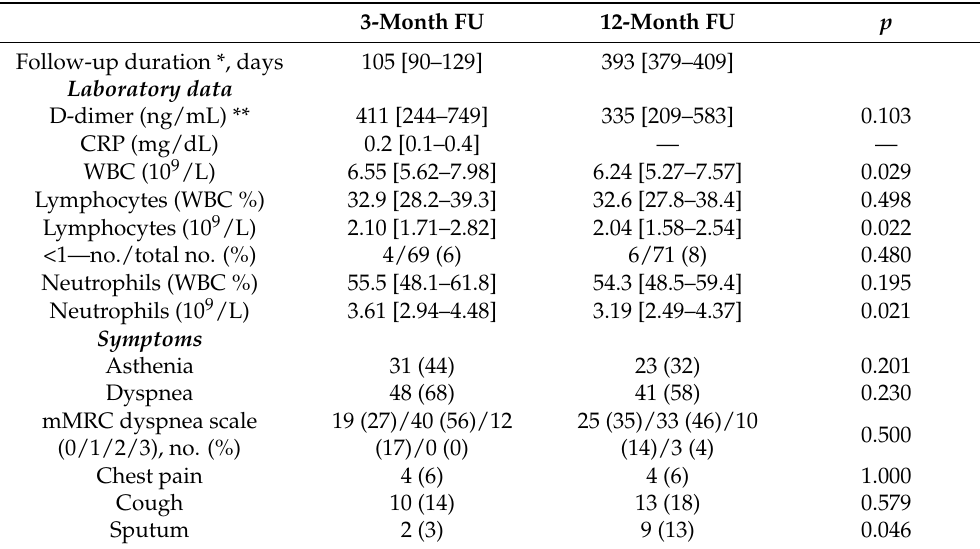
Table 2. Clinical and laboratory findings and patients’ reported outcomes in 71 COVID-19 survivors who underwent repeated clinical examinations up to 12 months after